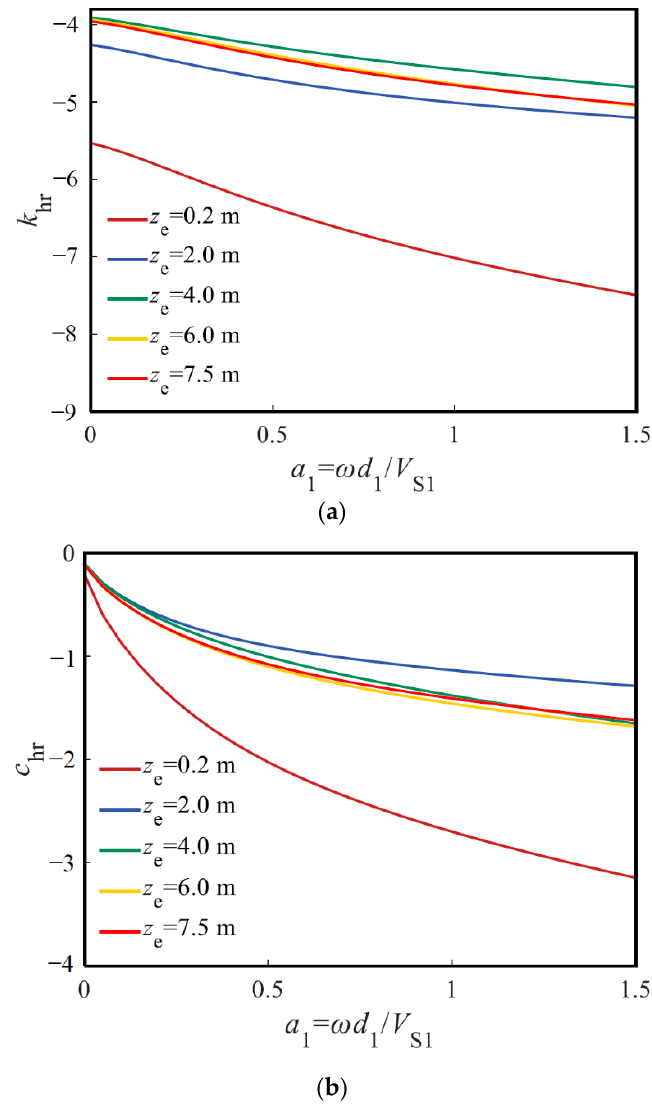
Figure 12. Influence of weak pile segment position on the HRDI of pile head. ( a ) Stiffness factor of HRDI and ( b ) damping factor of HRDI.